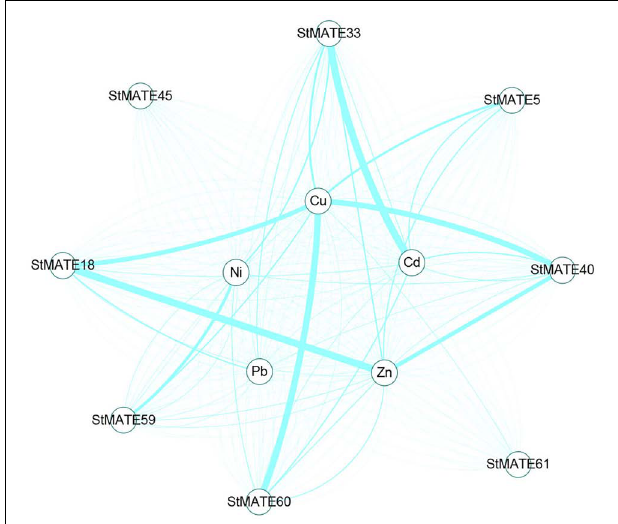
FIGURE 8 | Analysis of co-expression network of StMATE genes. The thicker the line between metals and genes indicates the higher expression of the gene under the metal stress